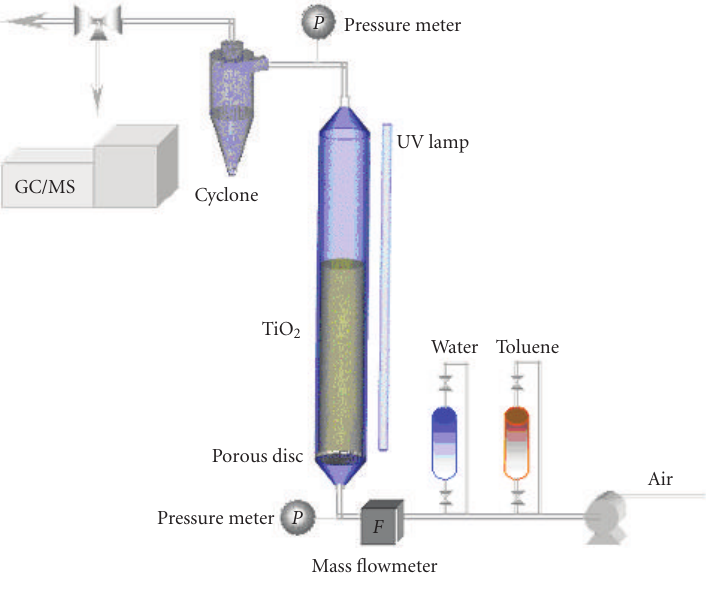
Figure 1: Schematic diagram of the fluidized bed